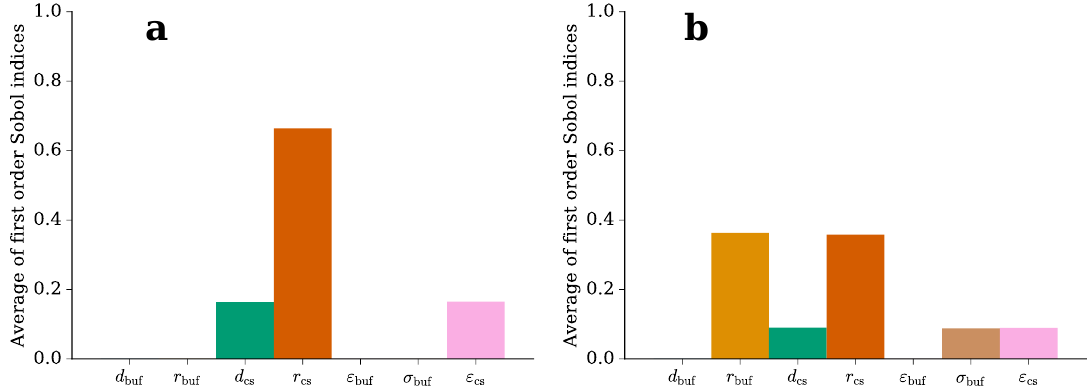
Figure 4. First order Sobol indices for ( a ) the absolute value of the impedance of the equivalent circuit (Equation (1)) and ( b ) for the electric field in the buffer medium (Equation